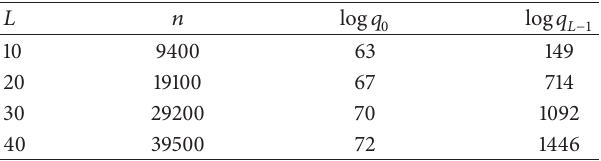
Table 1: The parameters of our